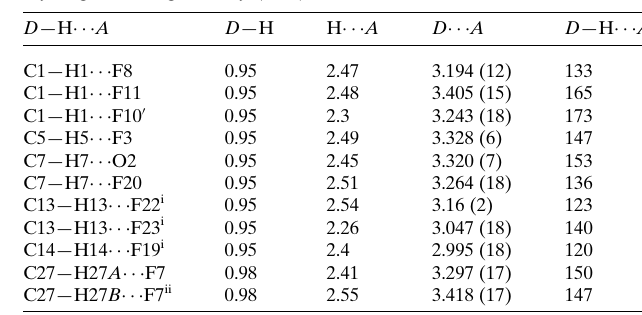
Table 1 Hydrogen-bond geometry (A˚ , (cid:3) ).